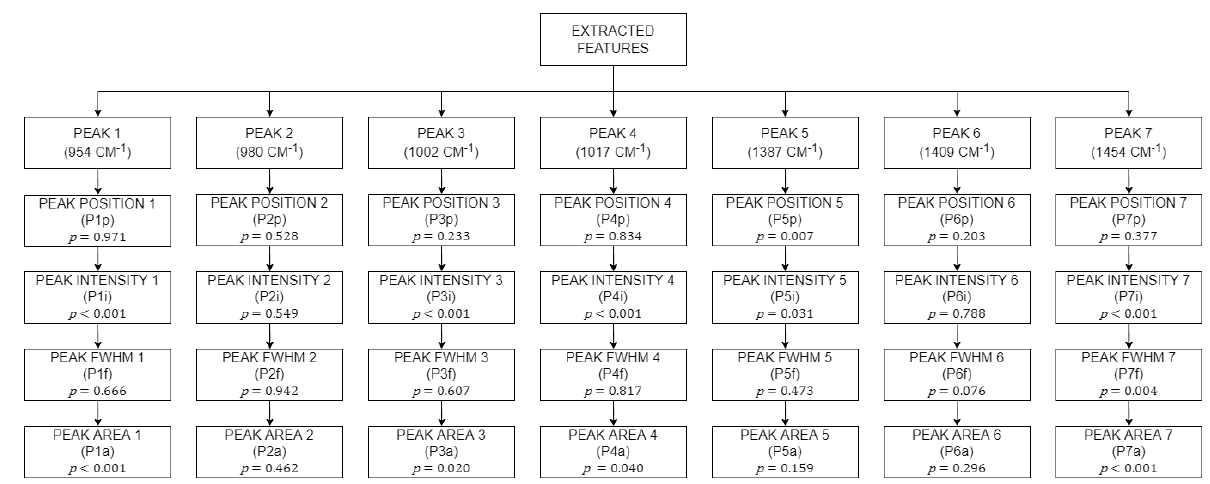
Figure 9. All extracted features from the 7 peaks from both areas including their p -values.